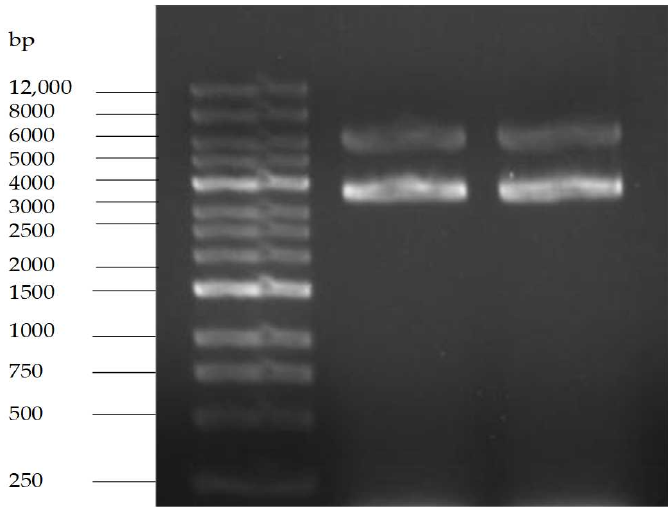
Figure 11. Agarose gel electrophoresis of pET28a.